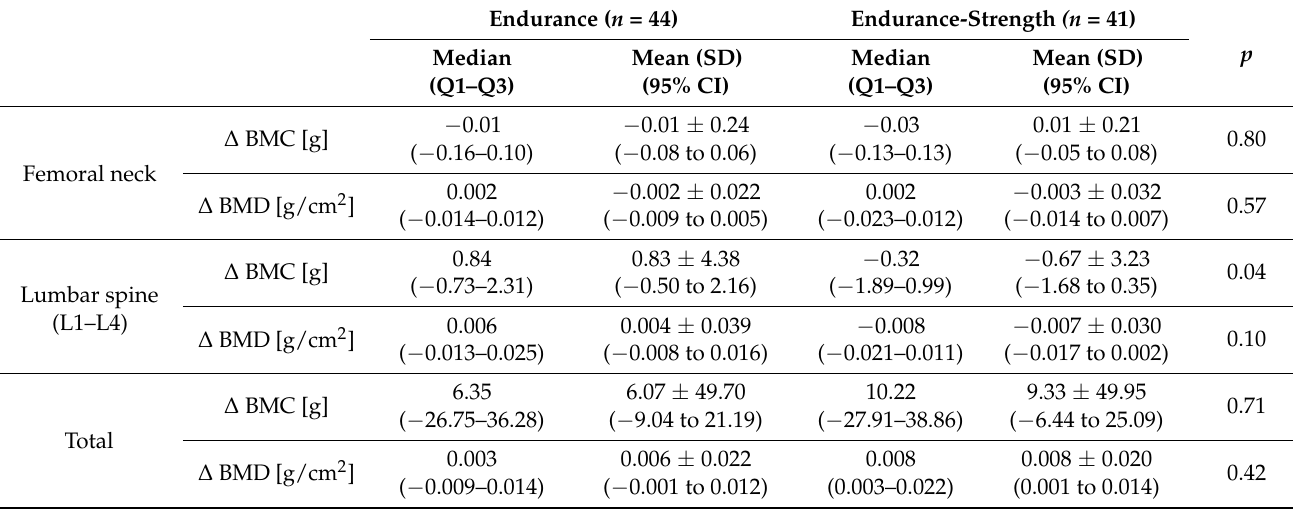
Table 5. Comparison of the effect of endurance ( n = 44) and endurance-strength training ( n = 41) on densitometric parameters.